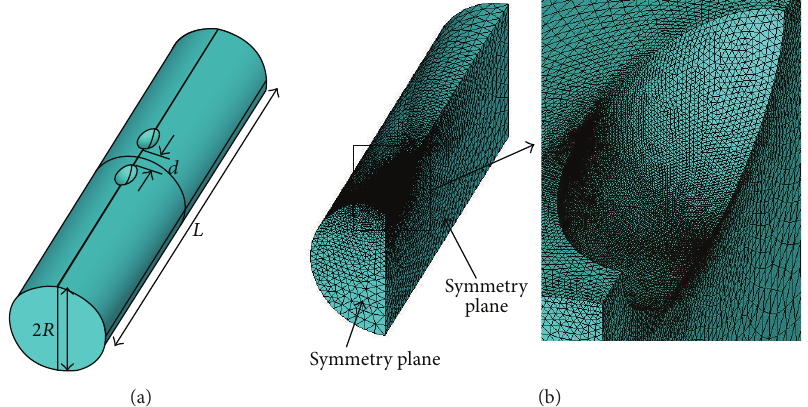
Figure 3: Illustration of two longitudinal pits’ problem: (a) geometric configuration of steel bar and corrosion pit; (b) finite element model.